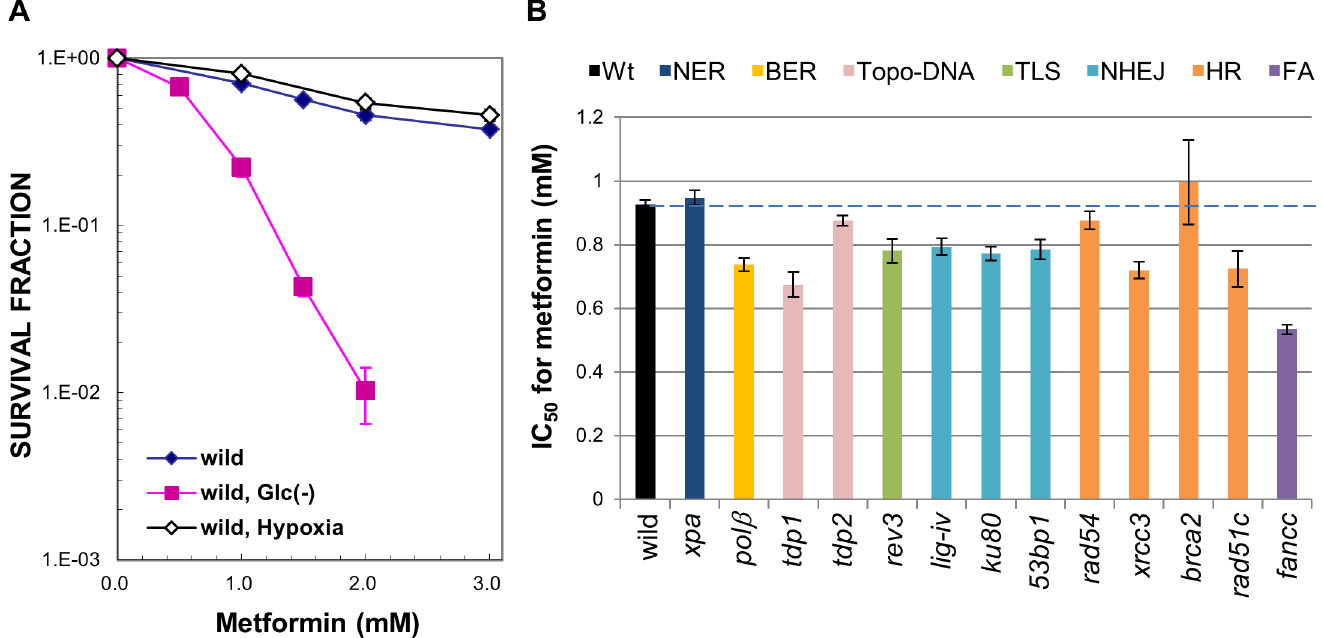
Fig 1. Toxicity of metformin and comparison of cellular sensitivities to metformin among various DNA repair-deficient DT40 cell lines under glucose-depleted conditions. (A) Wild-type cells were treated with the indicateddoses of metformin for 24 h in completemedium, no glucosemedium, or the 2% O 2 hypoxic conditionwith completemedium, and coloniesformed on methylcellulose-containing completemedia under normalconditionsfor 7 days. All data represent the mean ± S.D. normalizedto cells not treated with metformin from three independentexperiments. In each experiment, relative viabilities were measured as N/N 0 where N is the mean number of coloniesat each dose of metformin in treated cells and N 0 is the mean number of coloniesin untreatedcontrols; (B) Histogramsof the IC 50 values of metformin in the wild-type and various DNA repair-deficient cell lines. Cells were treated with metformin under glucose-depletedconditions for 24 h and coloniesformed on completemedia. All data represent IC 50 values ± 95% confidenceintervals normalized to cells not treated with metformin from three independent experiments. In each experiment, relative viabilities were measuredas N/N 0 where N is the mean numberof coloniesat each dose in metformin-treated cells and N 0 is the mean number of coloniesin untreated controls. Abbreviations: Wt, wild type; NER, nucleotide excisionrepair; BER, base excisionrepair; Topo-DNA, repair of DNA-topoisomerase (Topo) crosslinks; TLS, translation DNA synthesis; NHEJ, non-homologous end joining;HR, homologous recombination repair; FA, FA pathway(ICL repair).